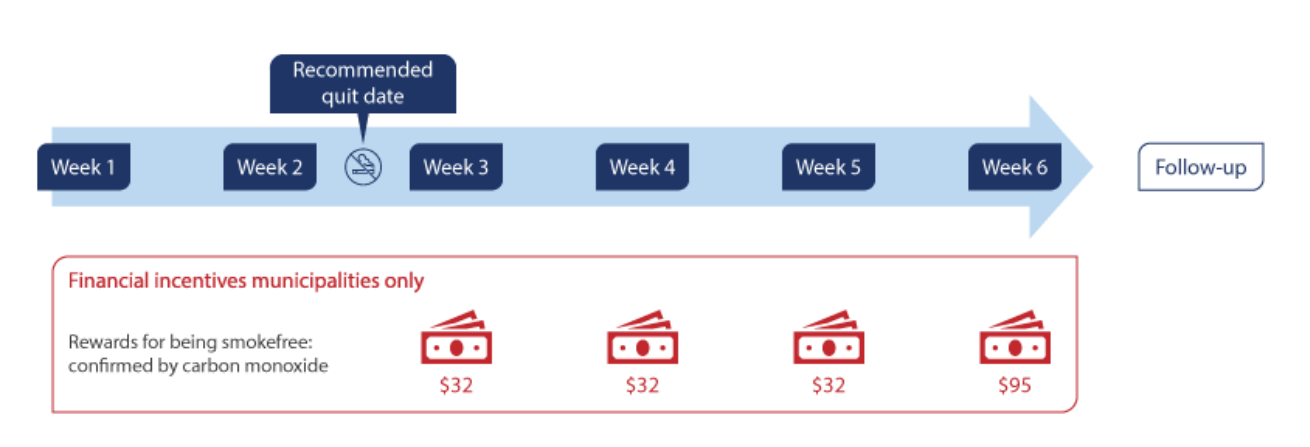
Figure A1. A graphical presentation of the timing and frequency of the meetings in the gold standard smoking cessation intervention used in both the financial incentives municipalities (FIM) and the campaign municipalities (CAM), and of the timing and amount of the rewards used in the FIM only.